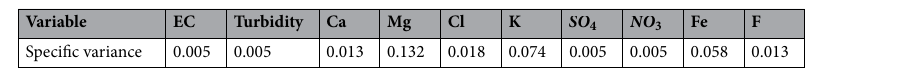
Table 5. Specific variance for factor